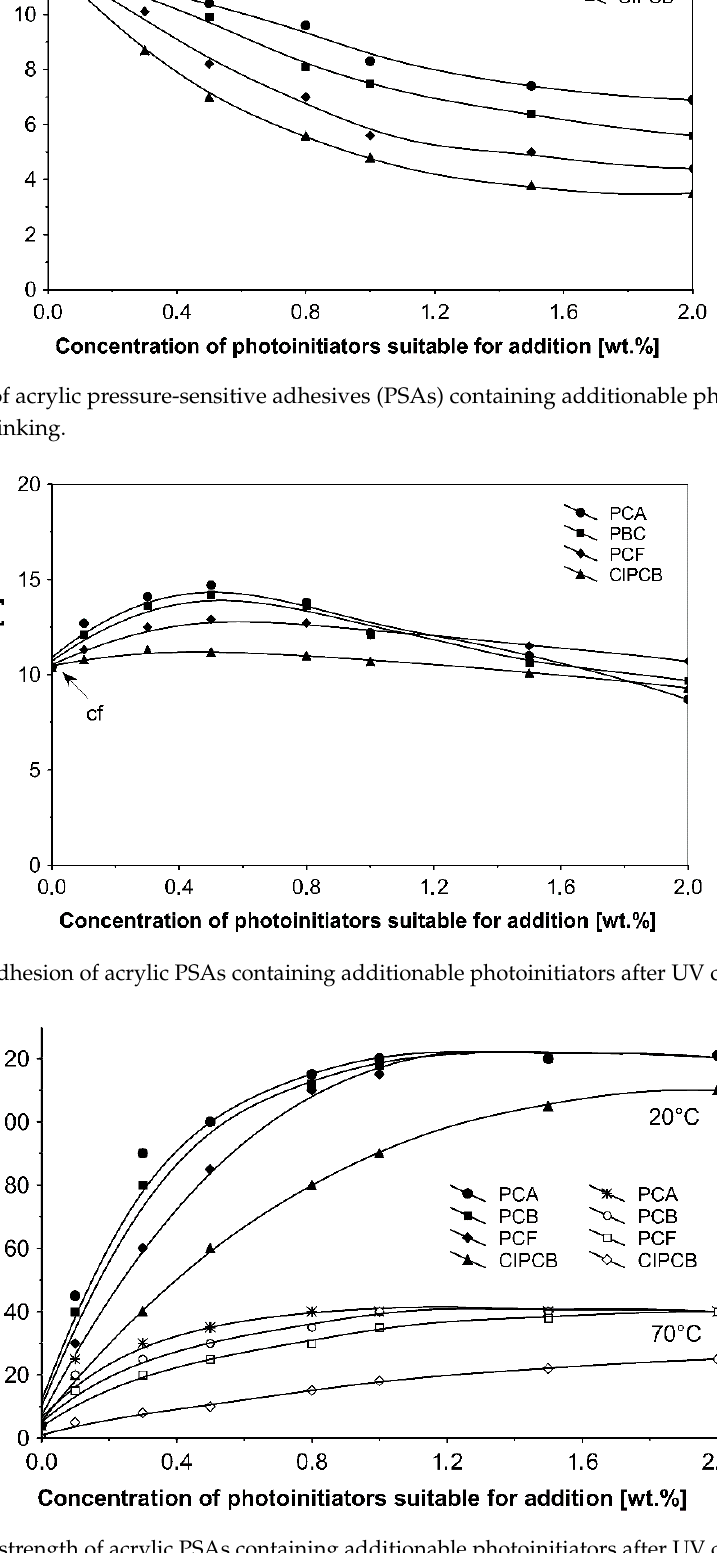
Figure 4. Shear strength of acrylic PSAs containing additionable photoinitiators after UV cross- linking .